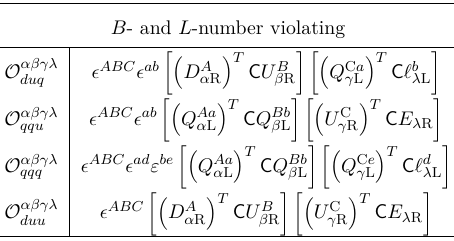
Table 5 . Baryon and lepton number violating four-fermion operators in the Green’s basis (and also in the Warsaw basis) in the